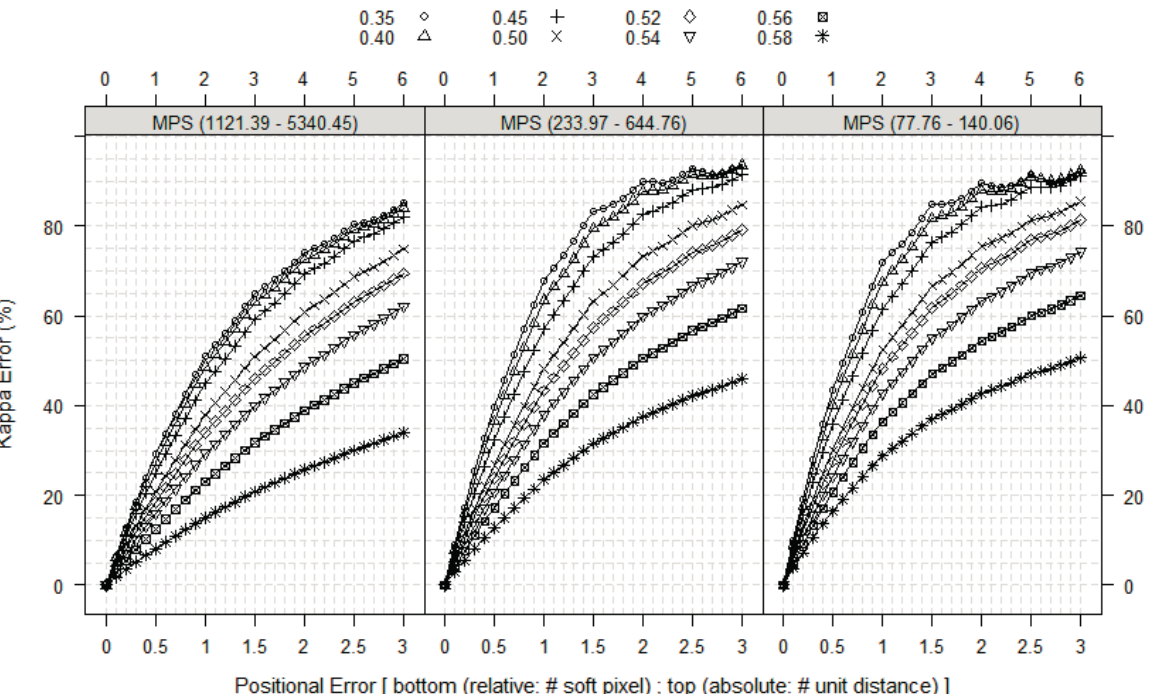
Figure 8. Impact of positional error on kappa-error at different landscape characteristics using a spatial resolution of 2 unit